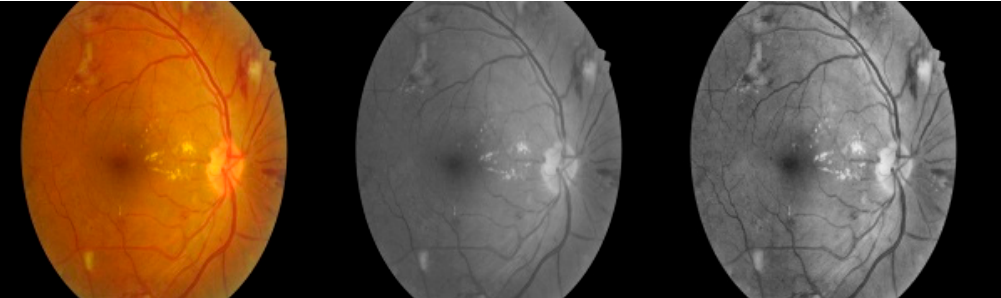
Figure 4. Resized image ( left ), grey image ( middle ), and after applying FC-CLAHE ( right ).